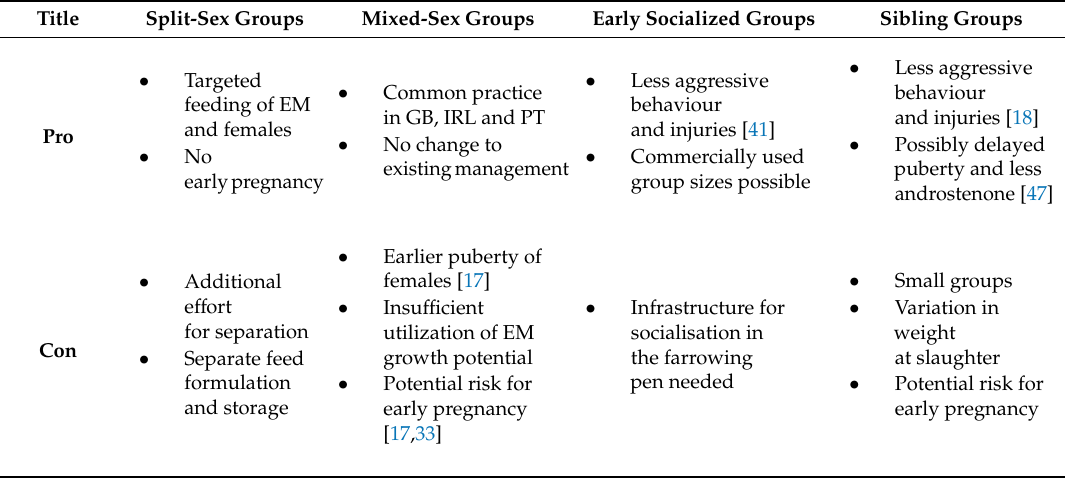
Table 1. Pros and cons for di ff erent group compositions with EM (adapted from